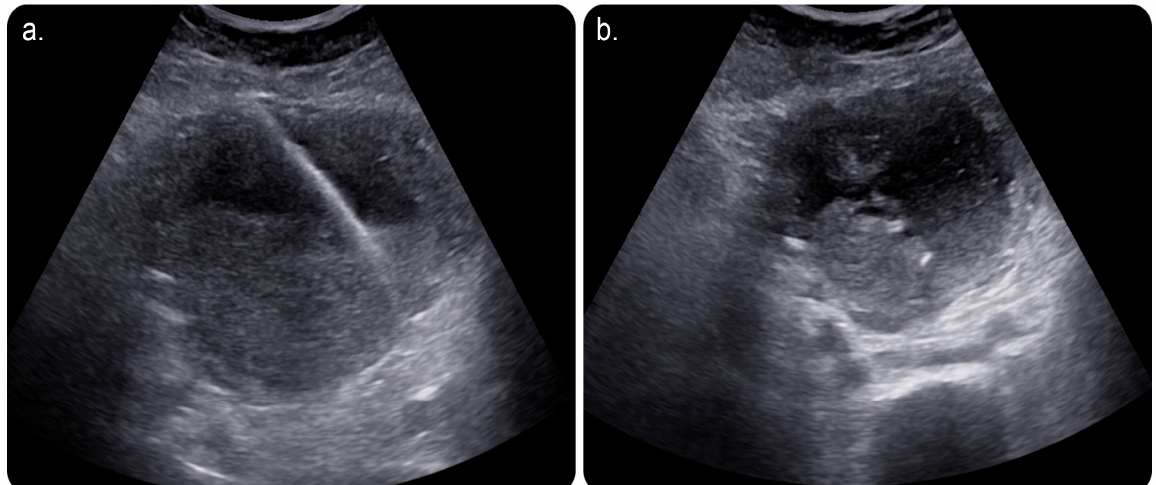
Figure 2. ( a ) Limited grey-scale ultrasound image of the uterus showing a percutaneous echogenic stiff wire inserted through the skin and subcutaneous layers; subsequently, it was secured in the endometrial cavity after an access was obtained using an 18-gauge needle. ( b ) Grey-scale ultrasound image showing a ring-shaped echogenicity at the dependant portion of the collection representing a 10-French-size pigtail catheter looped within the endometrial cavity.